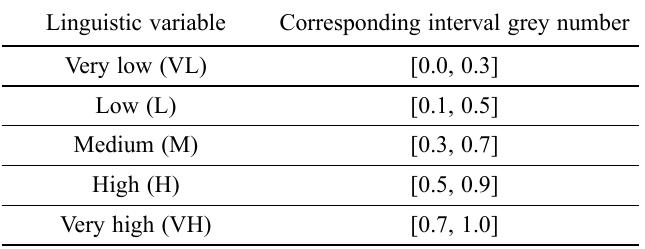
Table 1. Linguistic scales for a weights of criteria Linguistic